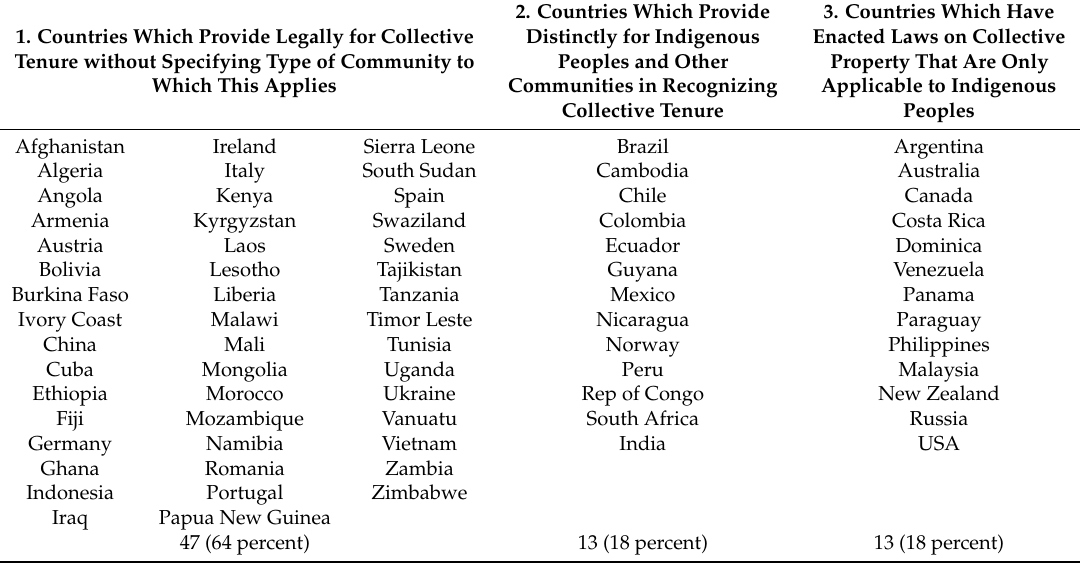
Table 6. Indigenous Peoples and other communities as targets in 73 tenure